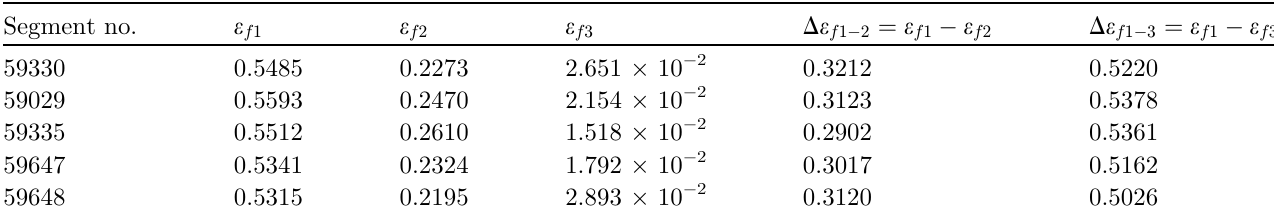
Table 6. Effective strain range of the dangerous area of the seal ring. Segment no.